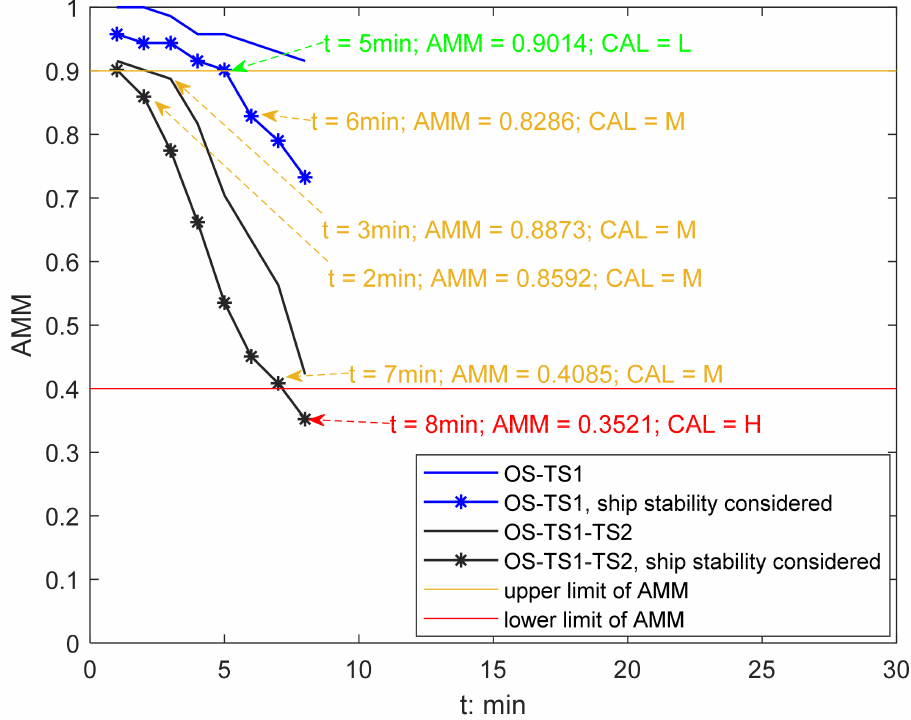
Figure 10. Illustration of the activation of AMM-based CAS from GW perspective in Scenario